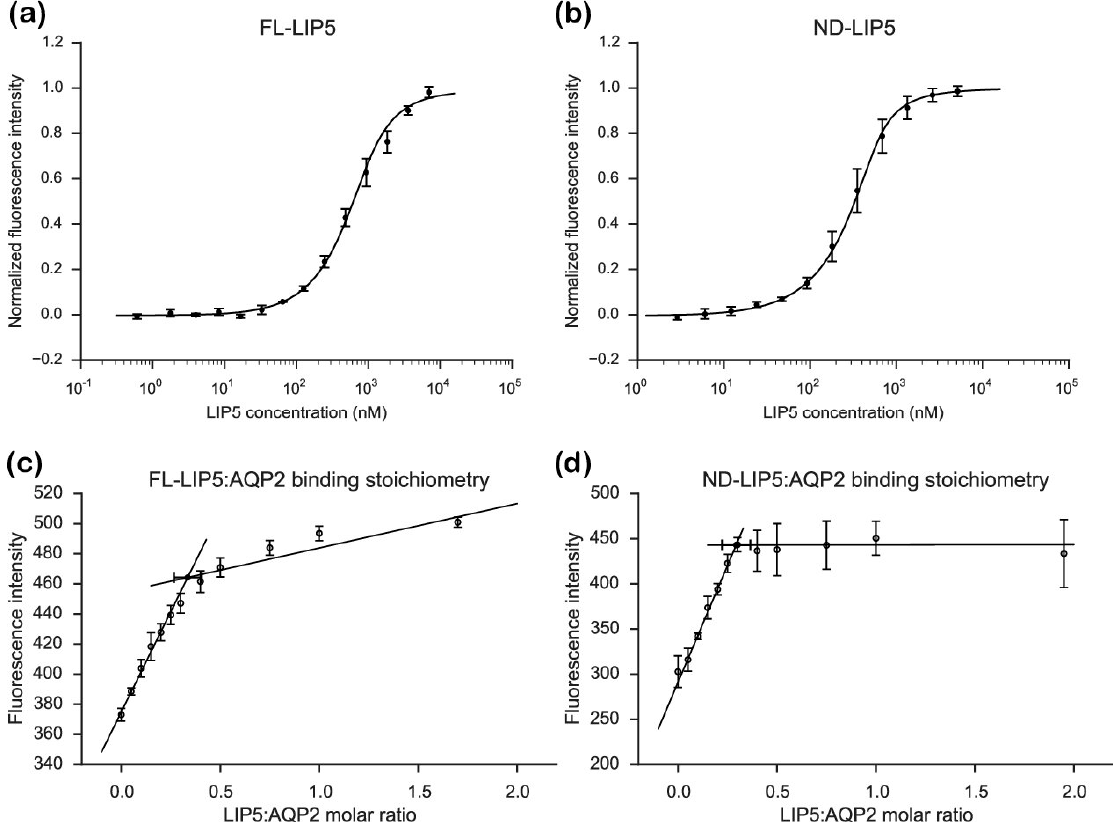
Figure 3. Fluorescence spectroscopy analysis of the interaction between LIP5 and AQP2. Binding curves for ( a ) full-length LIP5 (FL-LIP5) and ( b ) the N-terminal domain of LIP5 (ND-LIP5). Stoichiometry plot for ( c ) FL-LIP5 and ( d ) ND-LIP5 binding to AQP2. The molar ratio, determined from the saturation point (closed circle), was determined to be 0.42 ± 0.08 and 0.29 ± 0.07 for FL-LIP5 and ND-LIP5, respectively. Each curve was obtained from three independent titration series for which each point was measured three times.